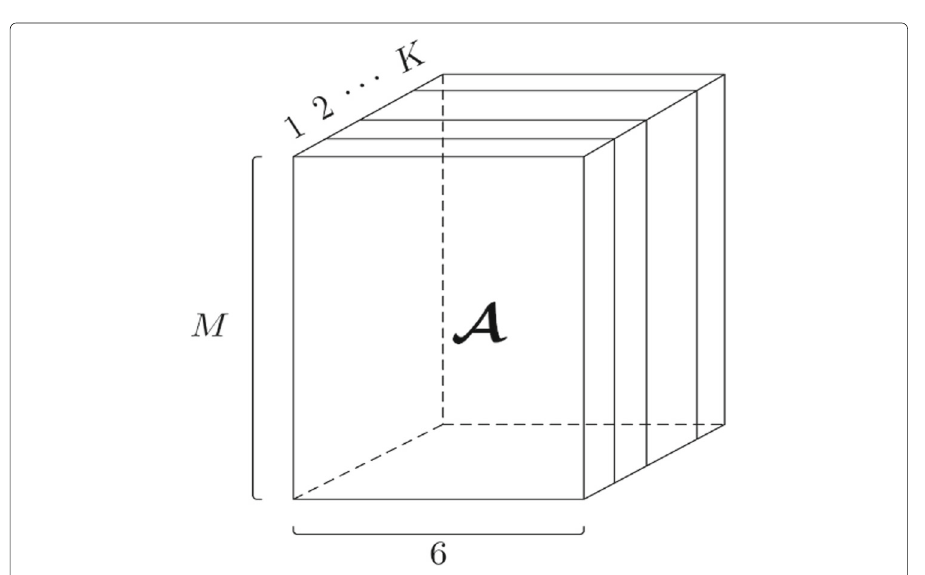
Fig. 3 The steering tensor of a six-component